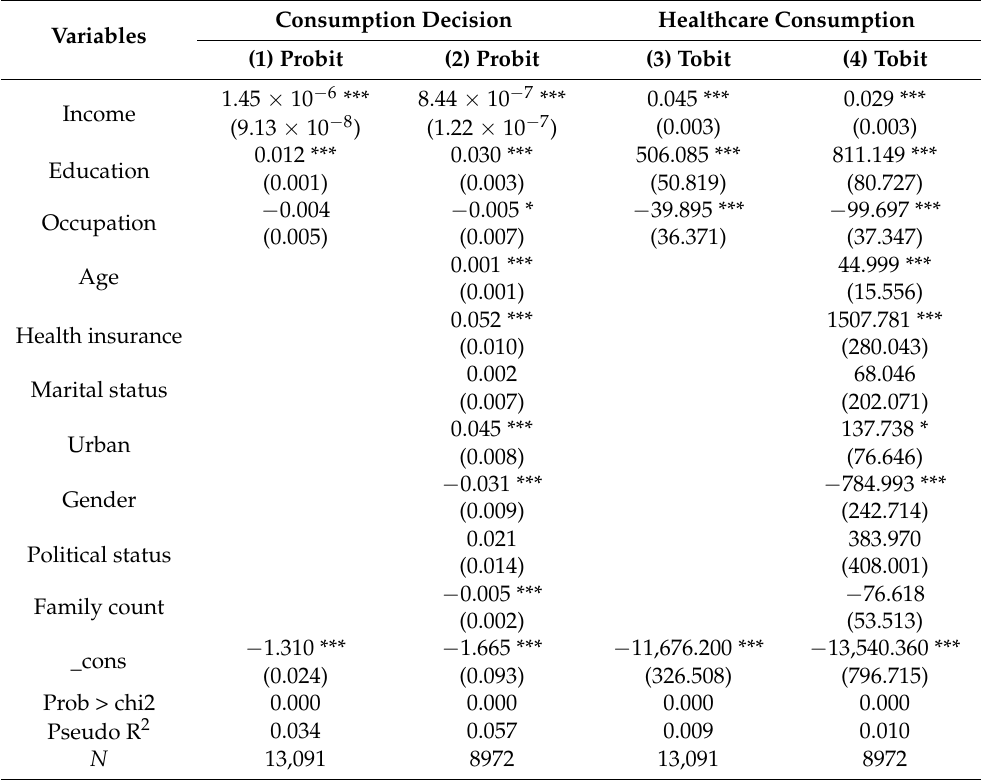
Table 3. The results of the impact of socioeconomic status on residents’ health care consumption decisions and